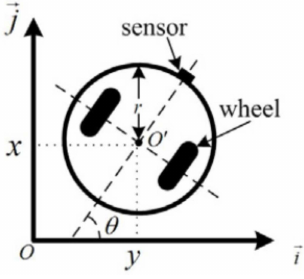
Figure 1. Sketches of the unicycle-like